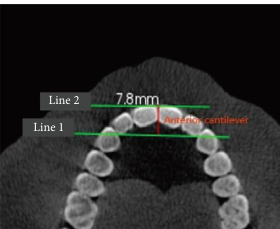
Figure 1: Representative images showing the linear measurements of the anterior maxilla that are used to determine dental arch forms according to “Misch’s classifcation.” Te frst line connected be- tween “canine cusp tips”; the second line was drawn that touched the most prominent area of the facial surface of the upper central incisor and was parallel to the frst line in the axial plane. Te distance between these two imaginary lines determines the type of arch